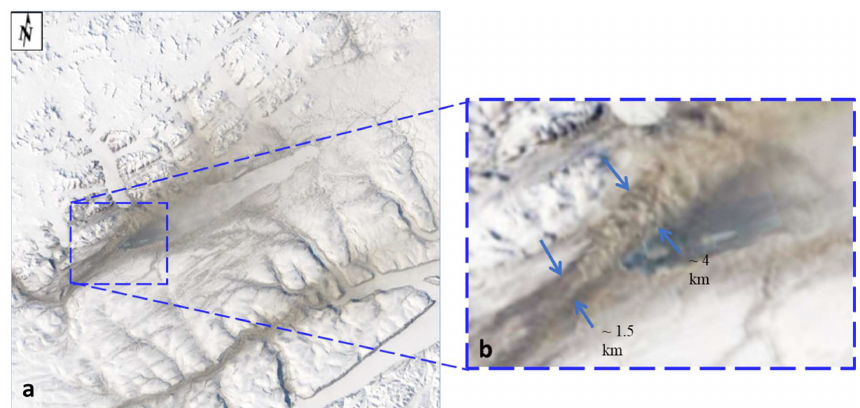
Figure 6. MODIS Terra satellite image on 19 May 2014 at 19:50UTC (a) . True-color image: MODIS channels 1 (620–670nm), 3 (459– 479nm), and 4 (545–565nm) were loaded into the RGB channels of the display. (b) The sub-image is a zoom of the most discernible part of the plume (outlined by the blue broken-line